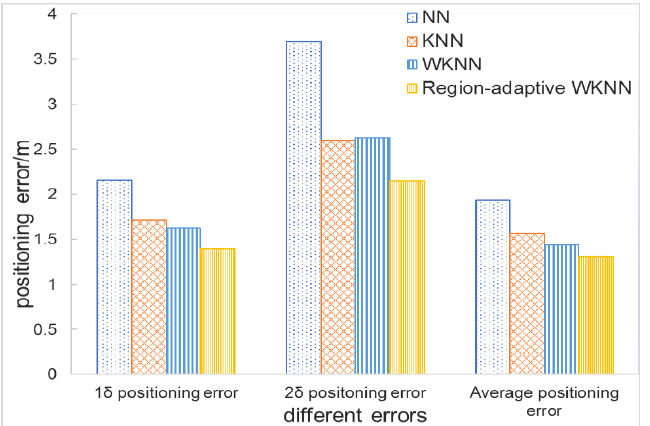
Figure 17. Comparison of different errors of different algorithms after calibration. (Testing mobile terminal 1).